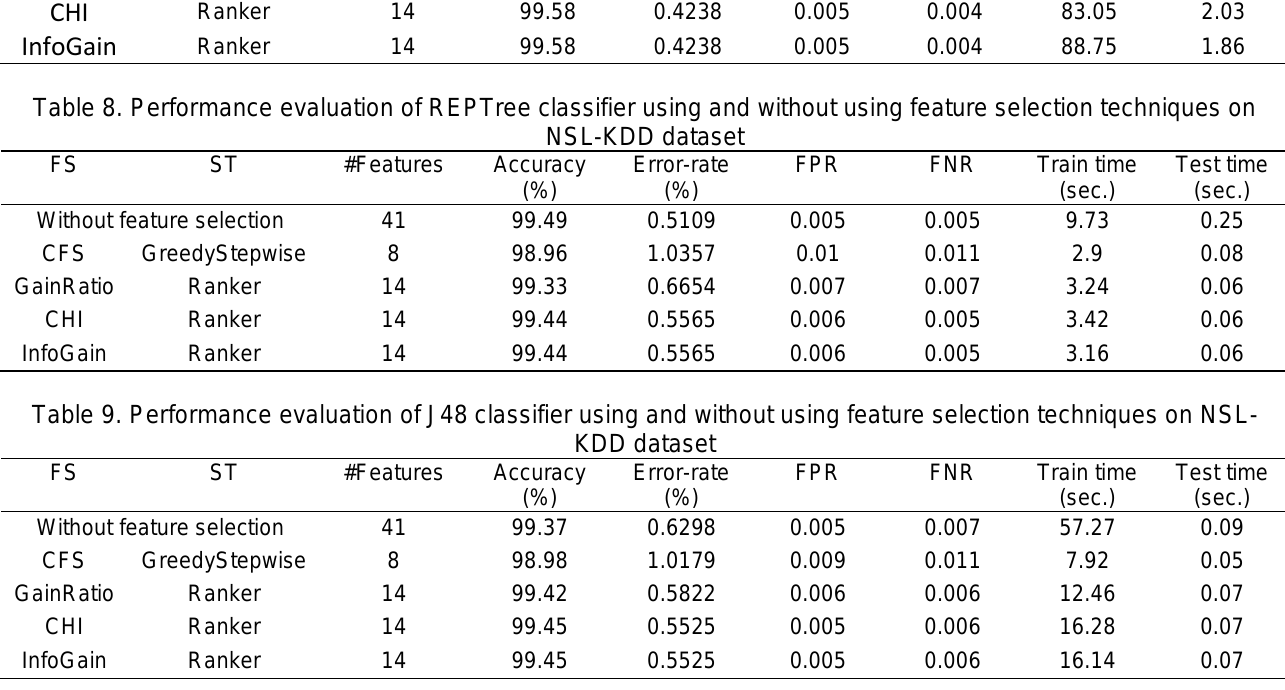
Table 10. Performance evaluation of AdaBoost classifier using and without using feature selection techniques